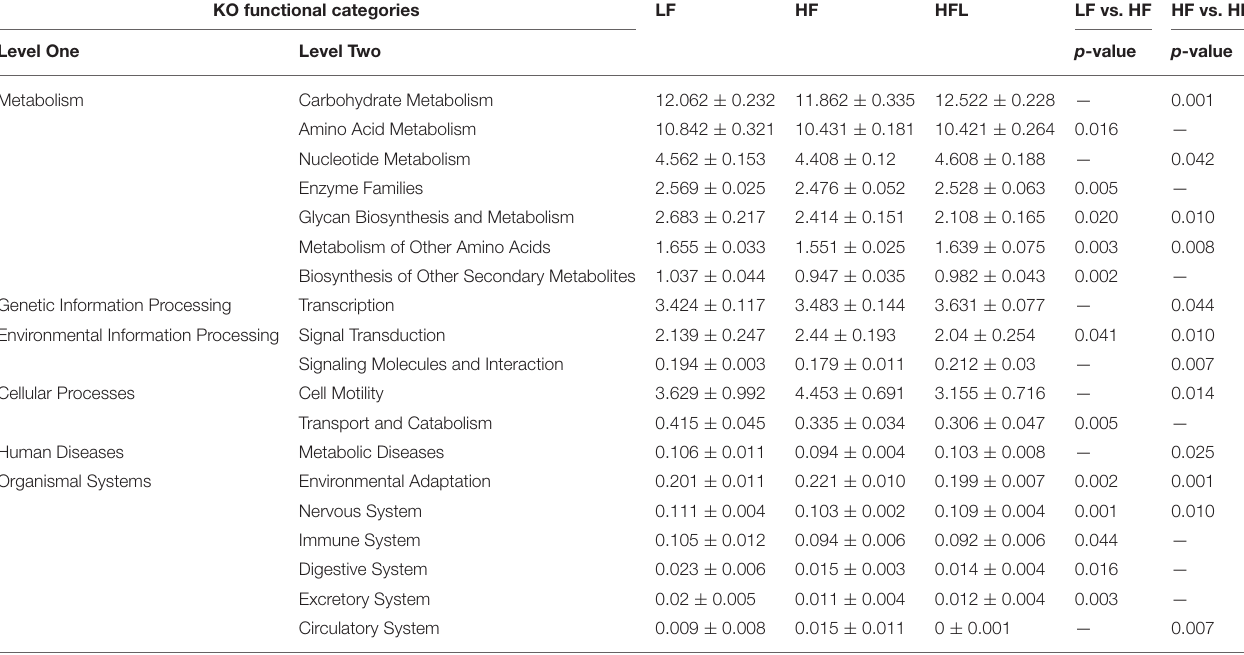
TABLE 1 | Predicted KEGG functional pathway differences at level 2 inferred from 16S rRNA gene sequence using PICRUSt after LF, HF and HFL